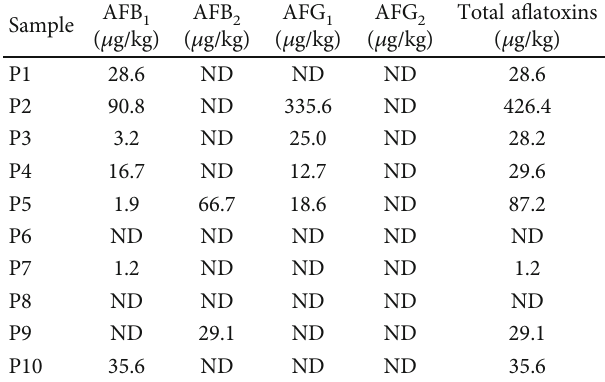
Table 2: A fl atoxin contamination levels in raw peanuts sold at Mbare musika